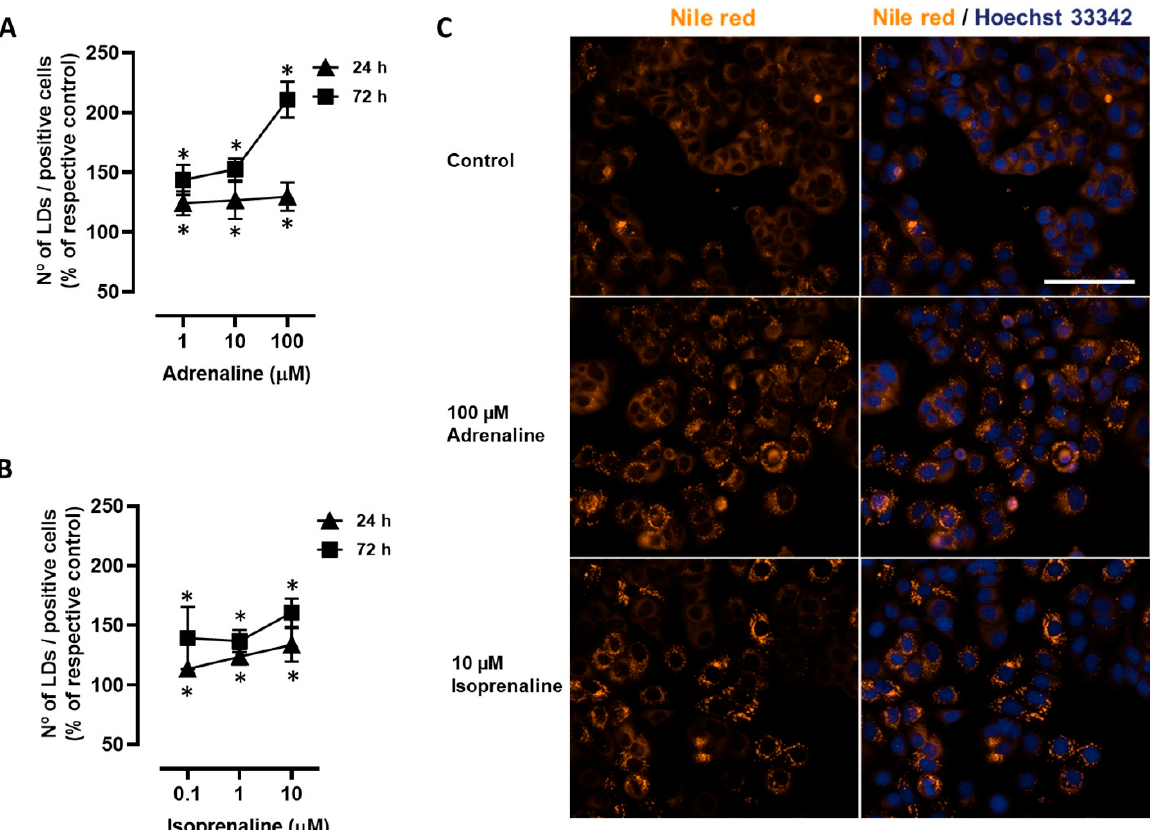
Figure 1. Influence of adrenoceptor activation on the number of lipid droplets (LDs)/positive cells in human MCF-7 breast cancer cells. Cells were treated with either ( A ) the non-selective adrenoceptor agonist adrenaline (1–100 µ M) or ( B ) the non-selective β -adrenoceptor agonist isoprenaline (0.1–10 µ M) for 24 h and 72 h. Results are expressed as percentage of control (solvent) and are presented as mean ± SD from 4 − 5 independent experiments. * p < 0.05, significantly different from solvent. ( C ) Representative microscopic images of LDs (orange fluorescence) in MCF-7 breast cancer cells without any treatment and after treatment, for 72 h, with either 100 µ M adrenaline or 10 µ M isoprenaline. Nuclei (blue fluorescence) were labelled with Hoechst 33342. Scale bar: 100 µ